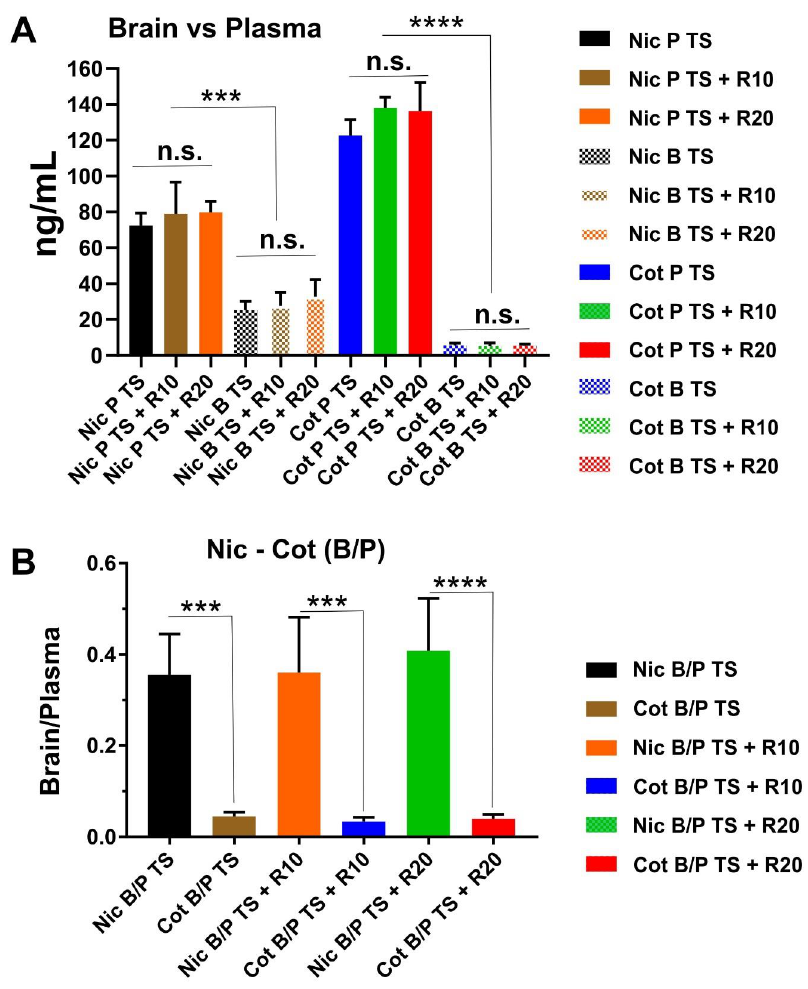
Figure 2. Plasma and brain levels of nicotine and cotinine in mice. ( A ) Side by side comparison of plasma “P” versus brain “B” levels, and ( B ) brain/plasma ratio of nicotine and cotinine across the main experimental groups, including TS exposed mice with and without RSG treatments. Note that nicotine and cotinine levels achieved across the various groups are not statistically different, thus indicating that levels of TS exposure achieved at the end of the 2 weeks among the test animals were very similar. Note also that differences in brain concentration between nicotine and cotinine, which correctly reflect the reduced blood–brain barrier (BBB) permeability to cotinine versus nicotine. n = 4 biological replicates. *** p < 0.001; **** p < 0.0001. n.s. = non statistical significance.